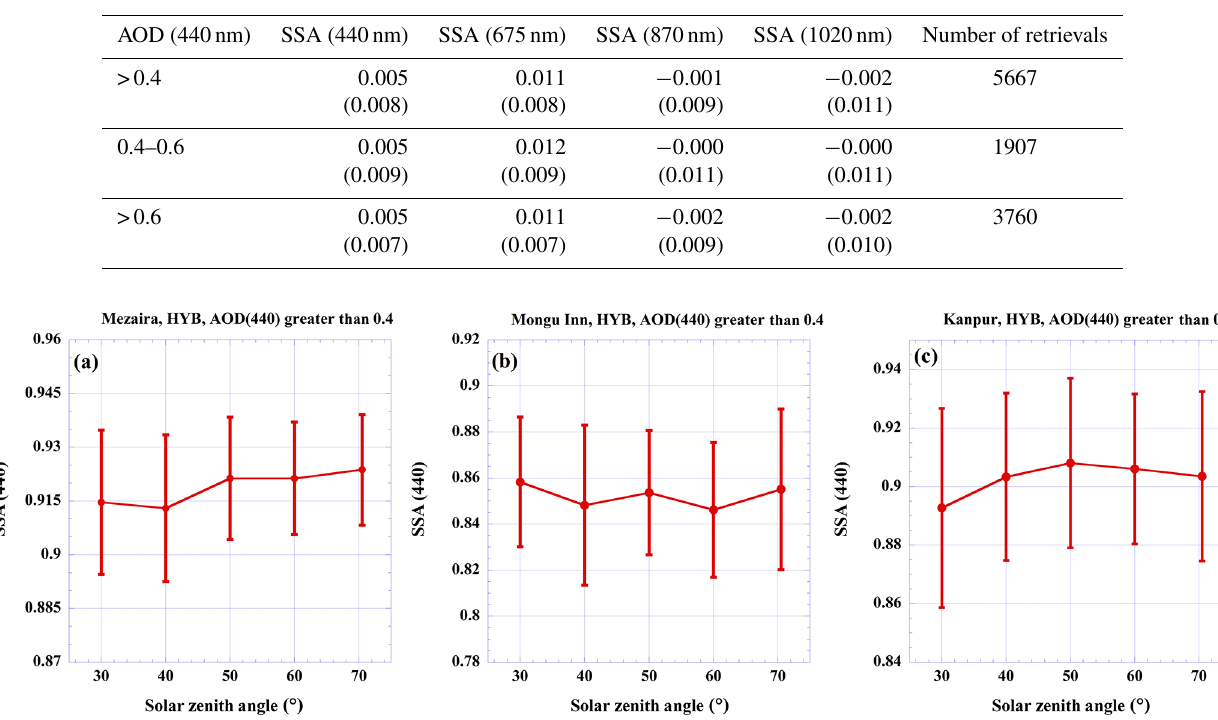
AOD values for water-soluble aerosols (smaller and greater than 0.2 at 440 nm) and for one AOD range (greater than